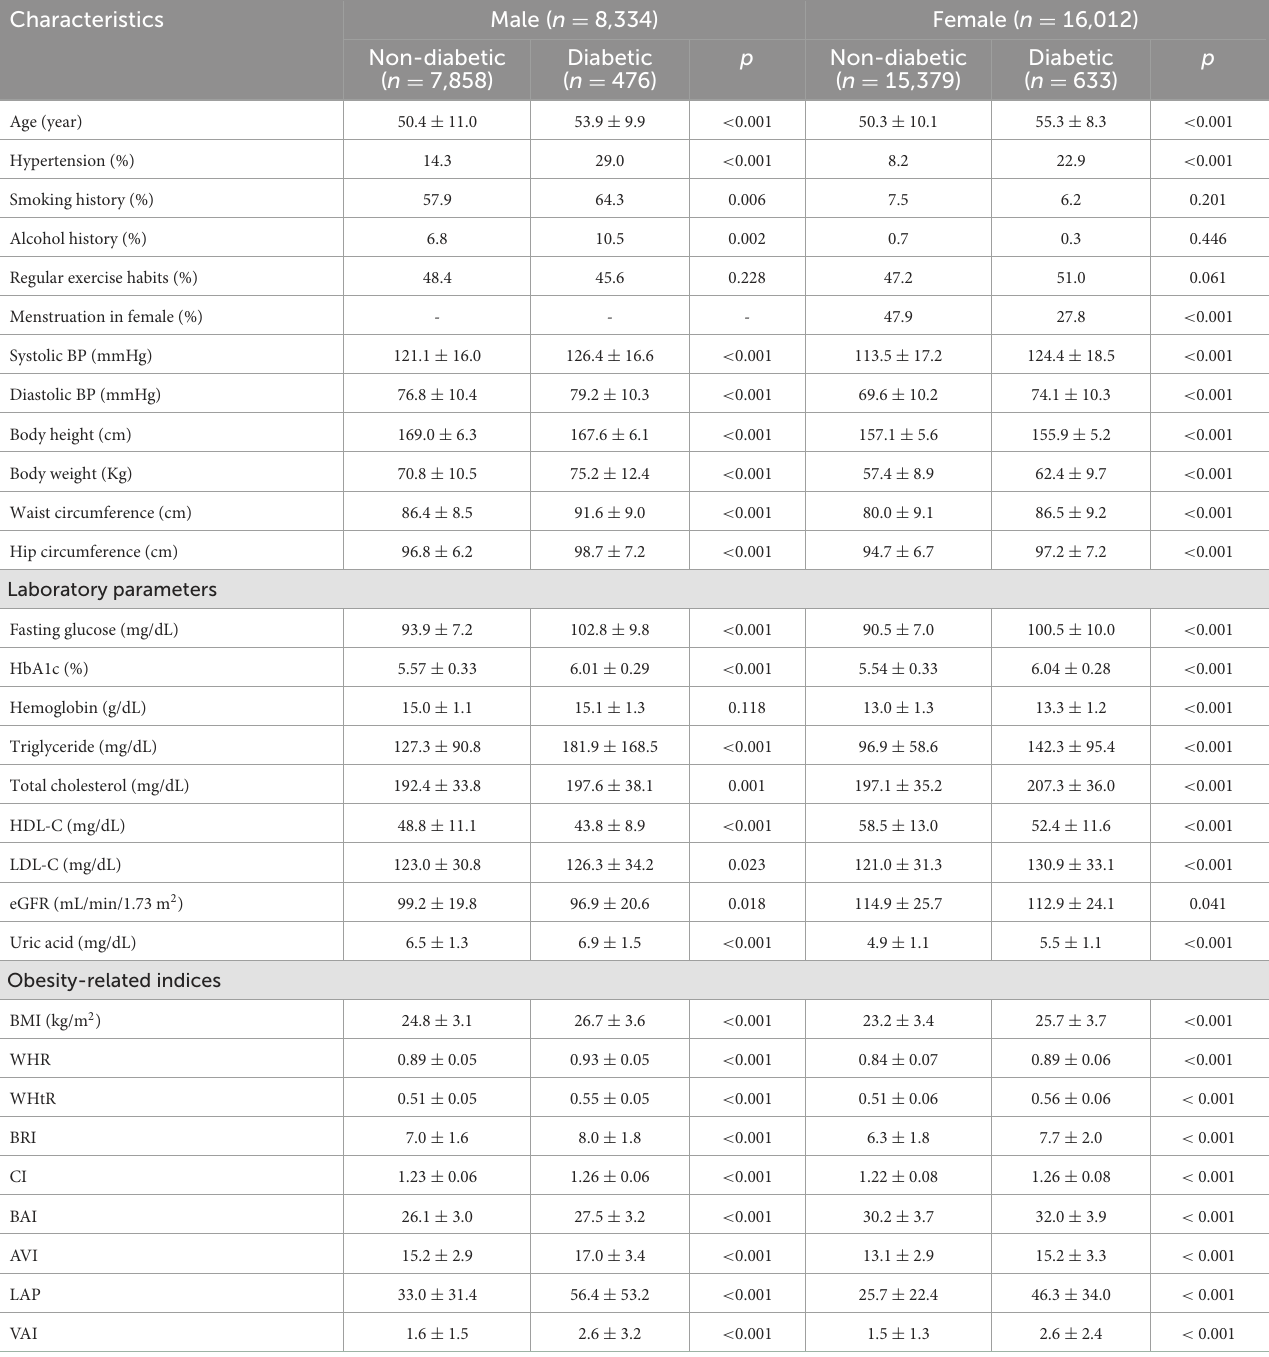
TABLE 2 Clinical characteristics of the study participants classified by the presence of different sex and incidence of DM.